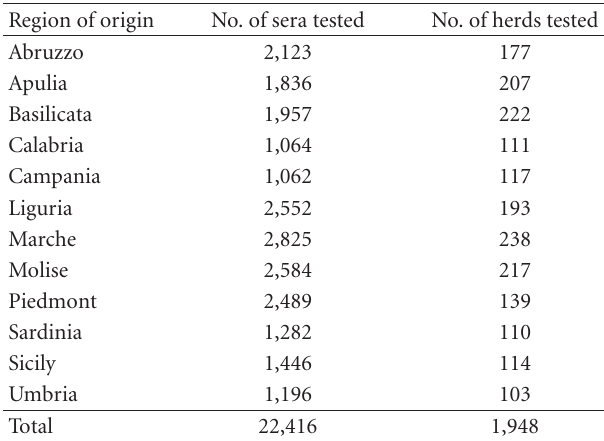
Table 1: Number of sera from the National Serum Bank (NSB, collected during the 2001–2003 period) and tested with RB51-CFT, on regional